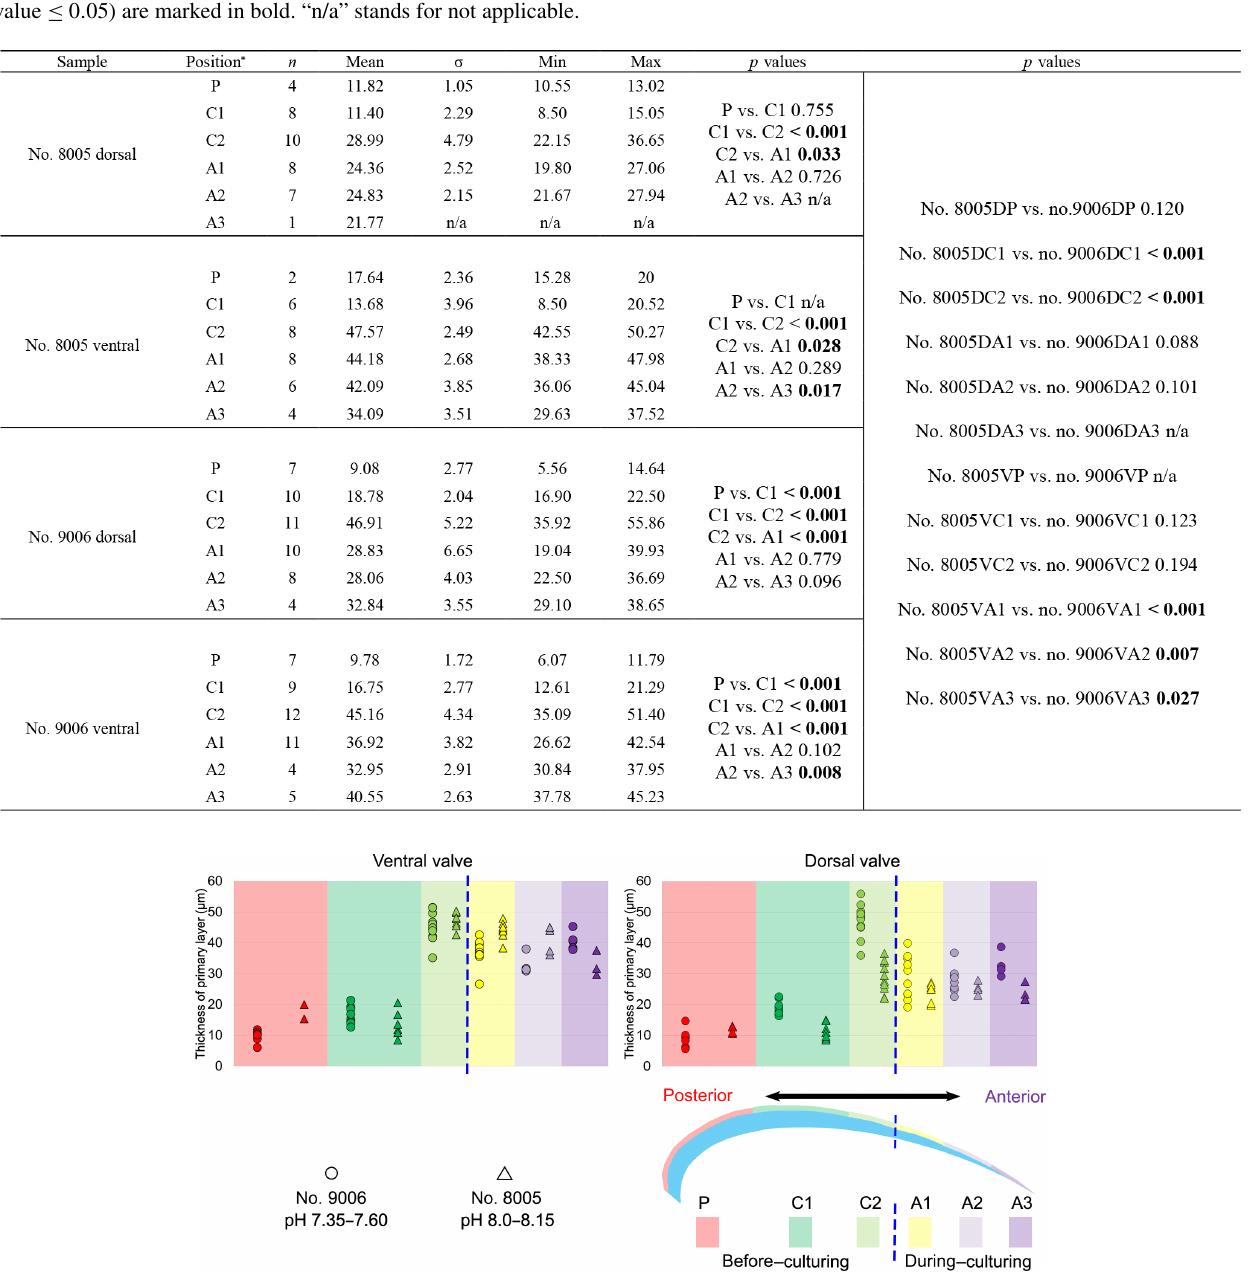
Figure 6. Variation of the thickness of the primary layer (ventral and dorsal valves) of a M. venosa specimen cultured at pH 7.35 and 7.6 (no. 9006) and a specimen cultured at pH 8.0 and 8.15 (no.